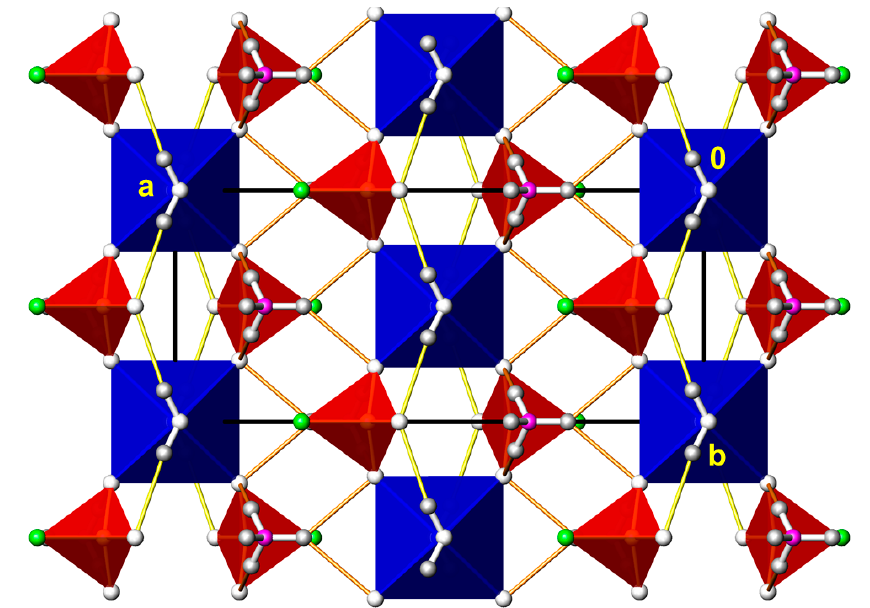
Figure 6. The crystal structure of (NH 4 ) 2 M (PO 3 F) 2 (H 2 O) 2 ( M = Mg, Co; data used from the Mg- compound) in a projection along [001]. Colour code of PO 3 F tetrahedra, H atoms and O–H···O hydrogen bonding as in Figure 1; [ M O 6 ] octahedra are given in blue, N atoms of the ammonium groups as magenta spheres. N–H···O hydrogen bonding is indicated by orange lines.